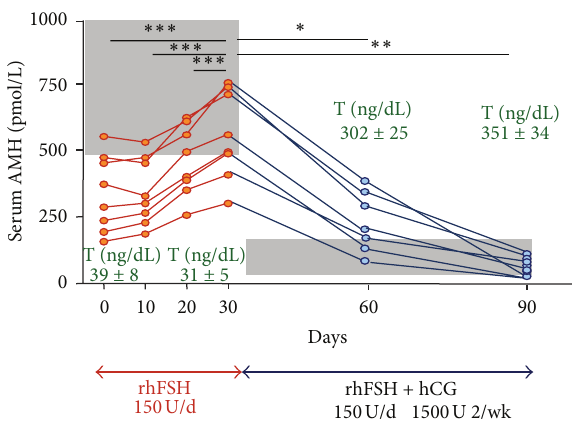
Figure 2: AMH levels in central hypogonadism. Serum AMH was low for Tanner stage I (prepubertal) in patients with previously untreated central hypogonadism. Initial treatment with recombi- nant human FSH (rhFSH) during 30 days resulted in an elevation of serum AMH in all 8 patients, while testosterone (T) remained at prepubertal levels. Shaded area represents normal AMH for Tanner I stage, according to T levels observed in these patients. Subsequent addition of hCG treatment resulted in an elevation of T which provoked a decline in serum AMH. Shaded area represents AMH values for Tanner IV-V stages, according to T levels observed in the treated patients. From [5], Copyright Karger AG, 2010, with